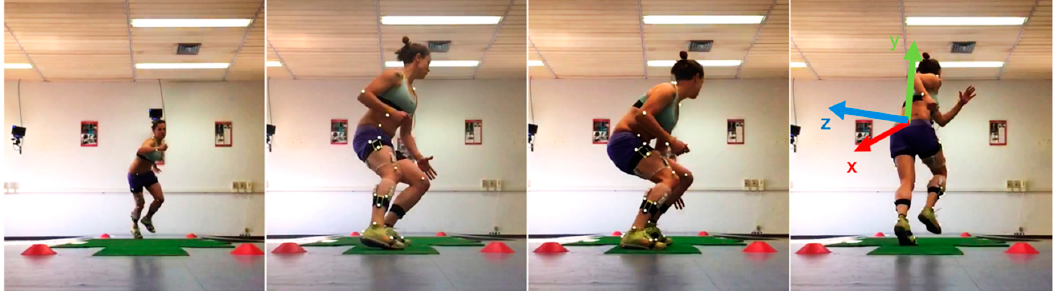
Figure 1. Experimental setting and turn (180-degree change of direction) action. In the right picture, the orientation of the sensor reference frame is displayed.